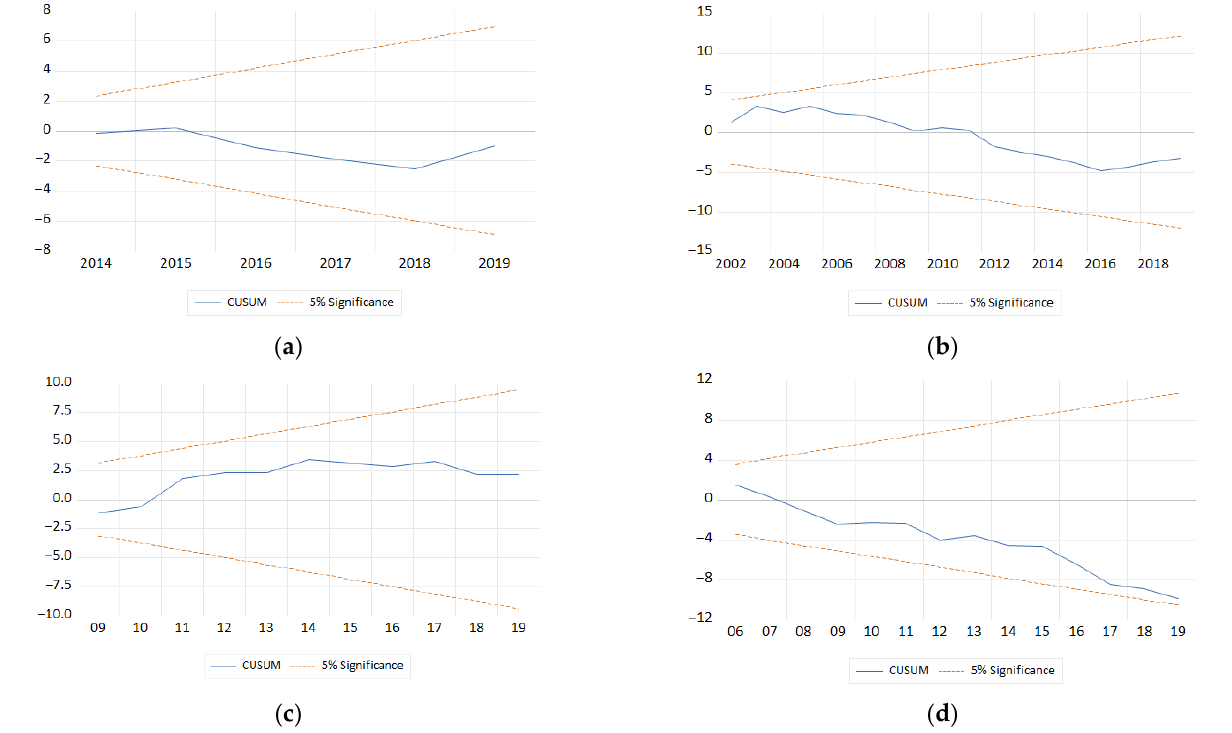
Figure A1. Czech Republic ( a ) (dep. variable CO 2 ). ( b ) Model 2 (dep. variable EC). ( c ) Model 3 (dep. variable GDP). ( d ) Model 4 (dep. variable FRT).